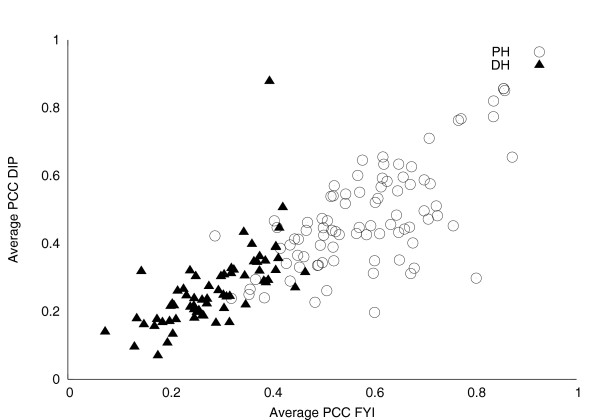
Co-expression in FYI and DIP. Average PCCs of the co-expressions of party hubs (PHs) and date hubs (DHs) and their interaction partners were calculated for the FYI-defined PH and DH. Average PCCs calculated for the interaction partners in the FYI network (x axis) correlate (CC = 0.8) with the average PCCs calculated within the DIP network (y axis). The values in the DIP network are on average lower.